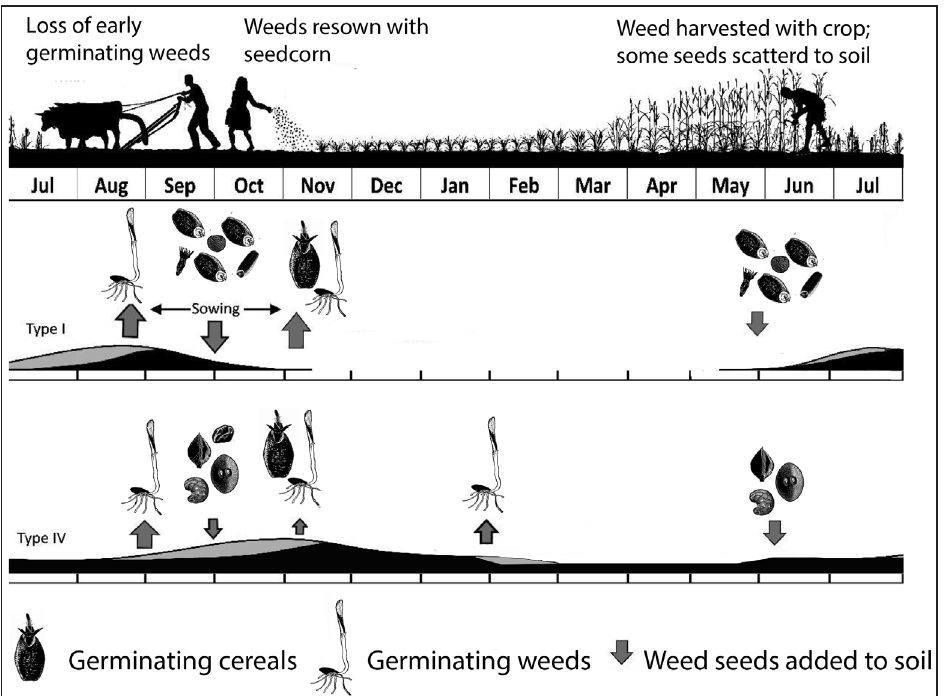
Figure 2: The relationship between the two major seed banks (Type I and Type IV) with the autumn sown crop cycles. Indicating periods of germination (losses from the seed bank) mainly relating to tillage, and additions to the seedbank from sowing and seed setting prior to and during